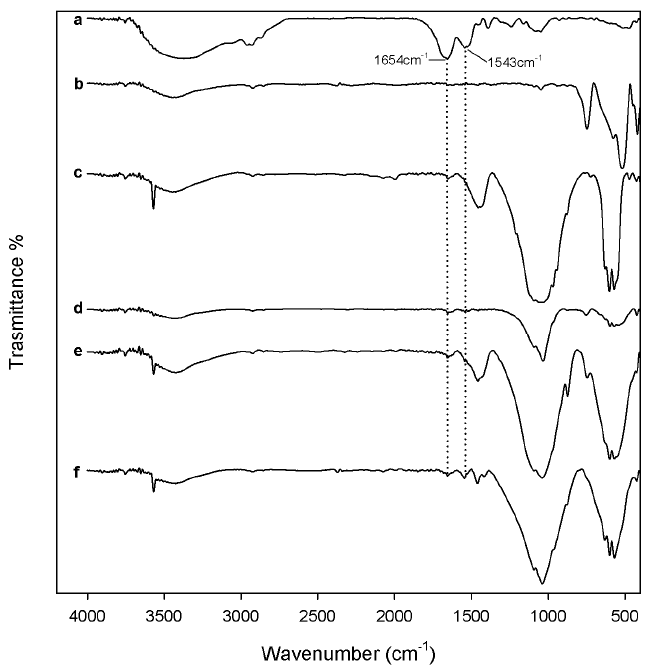
Figure 5. FTIR of ( a ) BSA and ( b ) ZrO 2 ; ( c ) Hap; ( d ) 9ZrO 2 ·1Hap; ( e ) 7ZrO 2 ·3Hap; and ( f ) 5ZrO 2 ·5HAp gels, heated to 1000 °C, after 24 h of exposure to BSA solution.